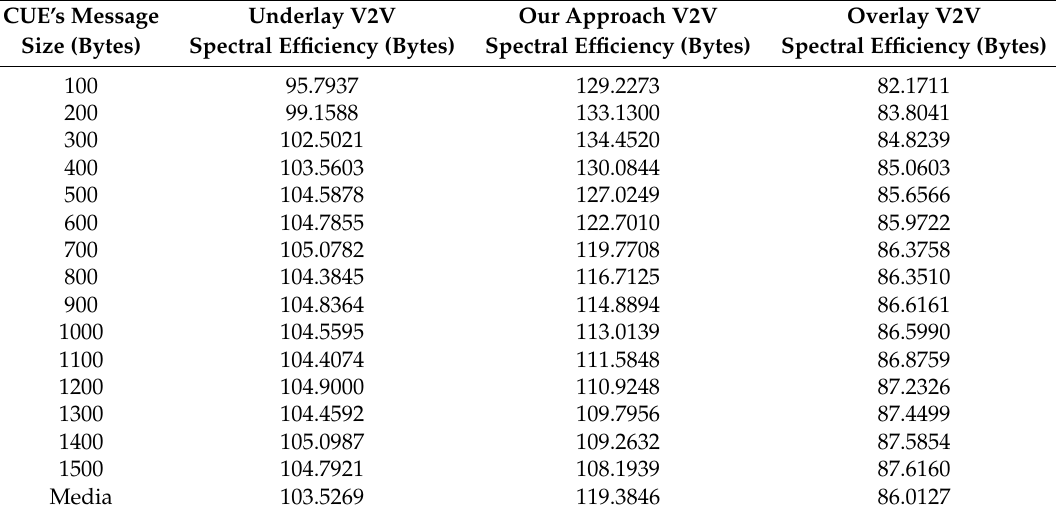
Table 6. Average Total Spectral Efficiency (bytes) achieved based on C-UEs’ traffic pattern.